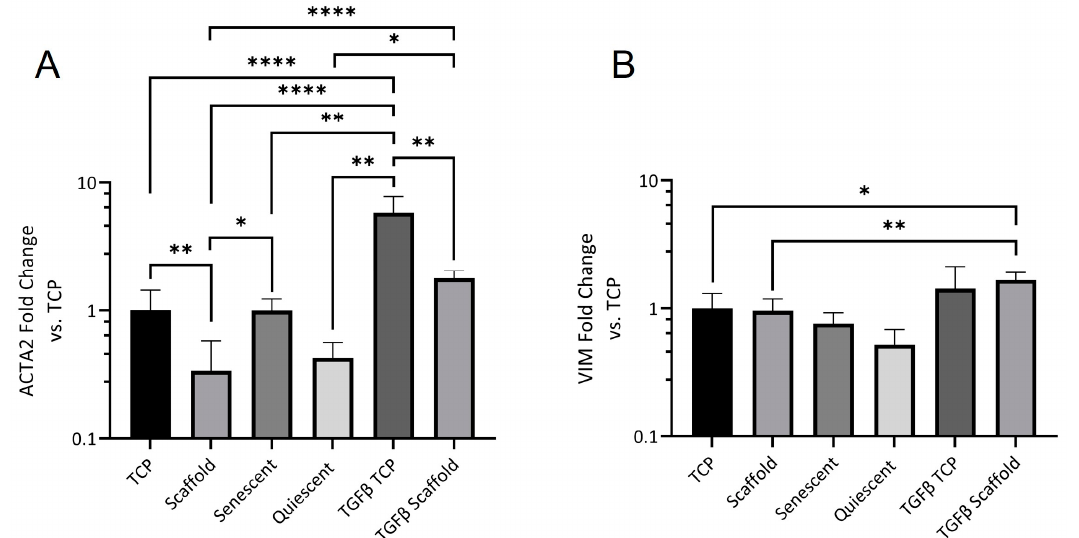
Figure 8. Graphs displaying qPCR results for cytoskeletal genes ( A ) ACTA2 and ( B ) VIM. Fold changes in gene expression are ‘vs’ TCP NOF and presented on a logarithmic axis. Comparison bars indicate significant differences: * p < 0.05, ** p < 0.01, **** p < 0.0001. Error bars represent standard deviation. TCP and scaffold (biological replicates = 9, technical replicates = 3), Senescent and Quiescent (biological replicates = 3, technical replicates = 3). TGF β TCP and Scaffold (biological replicates = 6, technical replicates = 3).